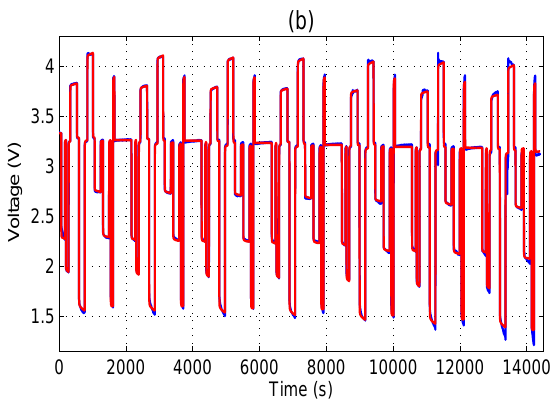
Figure 6. ( a ) Experimental and identification results of hybrid pulse test: WB ‐ LYP40AHA; ( b ) Experimental and identification results of hybrid pulse test: LiFePO 4 .